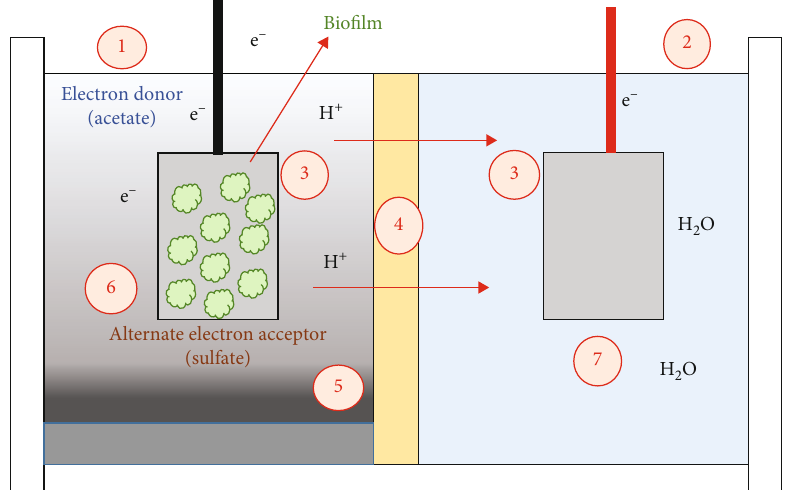
Figure 1: MFC type “ H ” : anodic chamber (anaerobic) (1); cathodic chamber (aerobic) (2); graphite cloth (electrode) (3); cation exchange membrane (4); sulfate reducing inoculum (5); mineral medium (6); distilled water